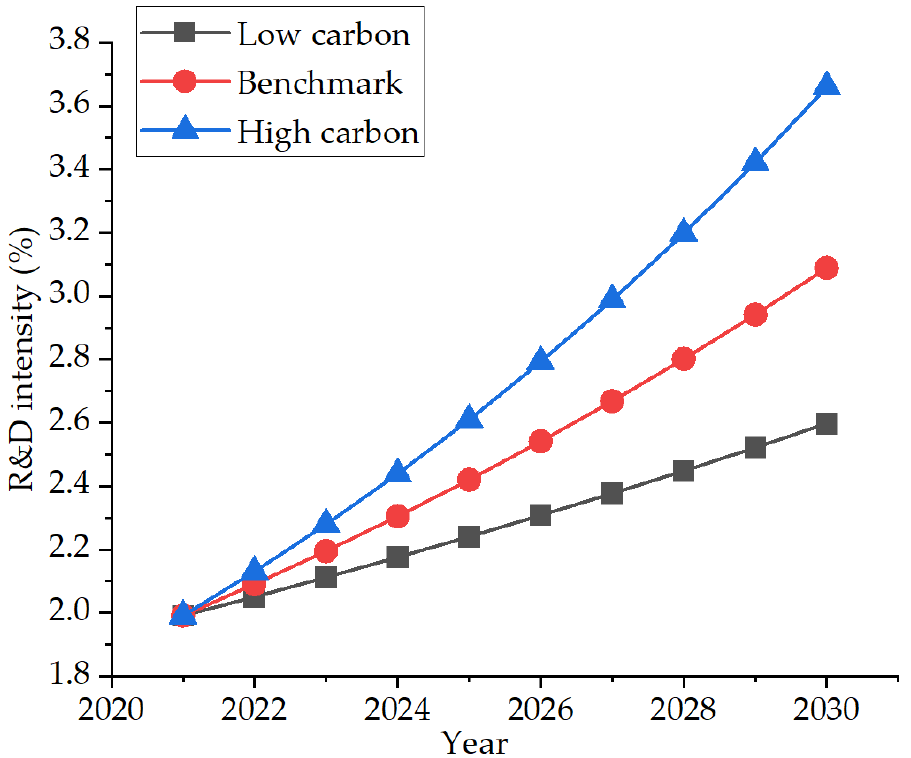
Figure 10. Three R&D intensity development scenarios .